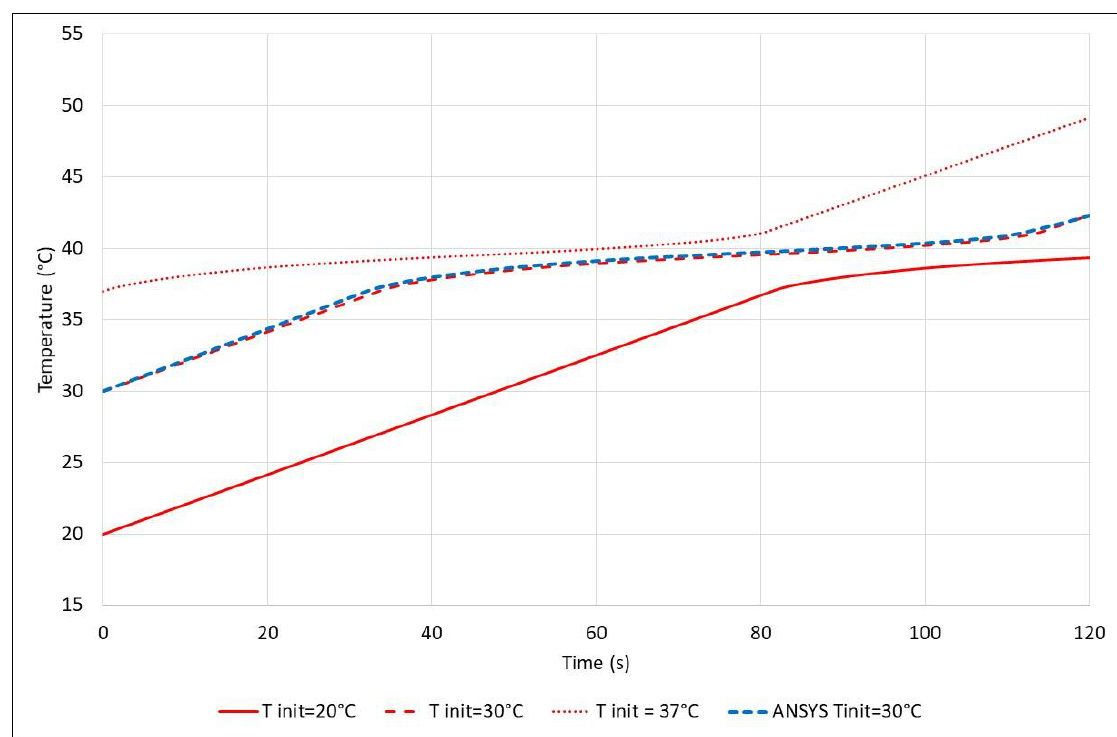
Figure 5. Calculated average temperature of the battery HSS during a 0.5-C discharge for different initial temperatures of the pack.